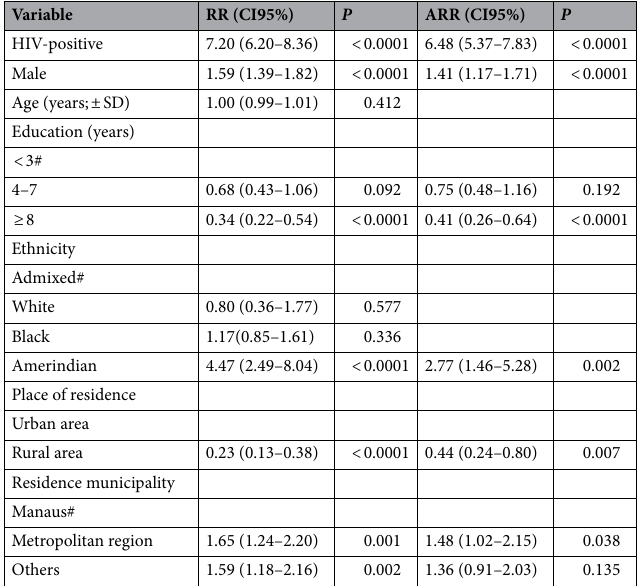
Table 2. Impact of HIV-status and other variables on P. vivax malaria incidence in the state of Amazonas, Brazil, 2012–2020. # Reference groups.